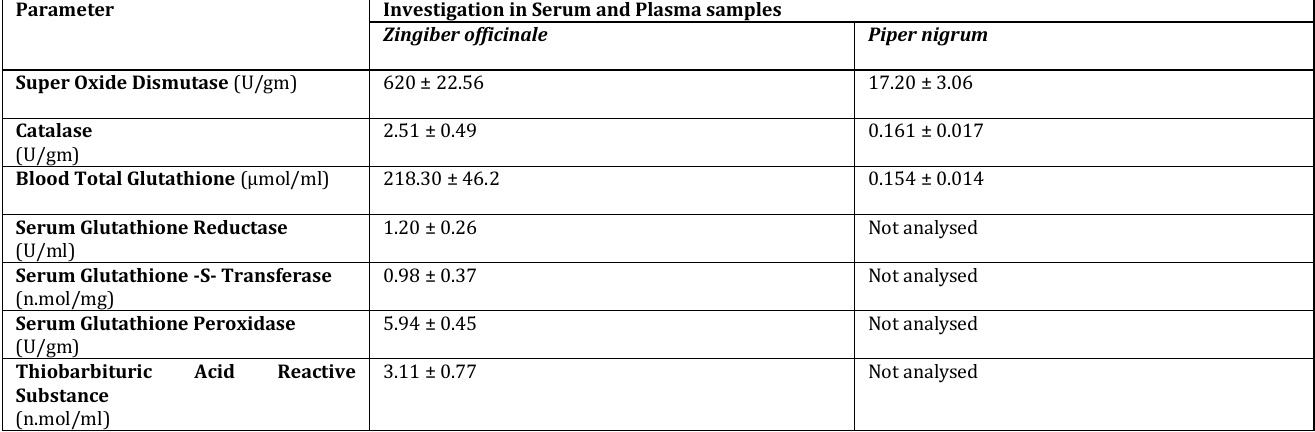
Table 3: In vivo anti-oxidant activity of plants.